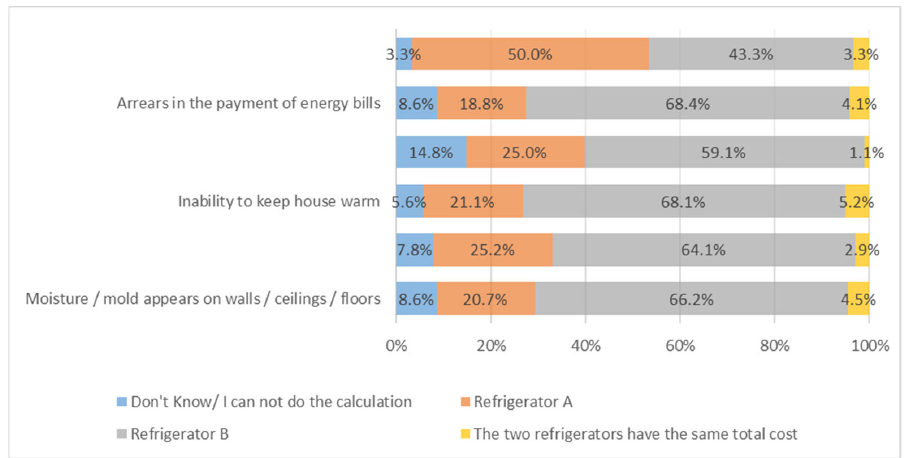
Figure 14. Energy ‐ related financial literacy investigation by energy ‐ vulnerable and non ‐ vulnerable Figure 14. Energy-related financial literacy investigation by energy-vulnerable and non-vulnerable households—subjective indicators. households—subjective